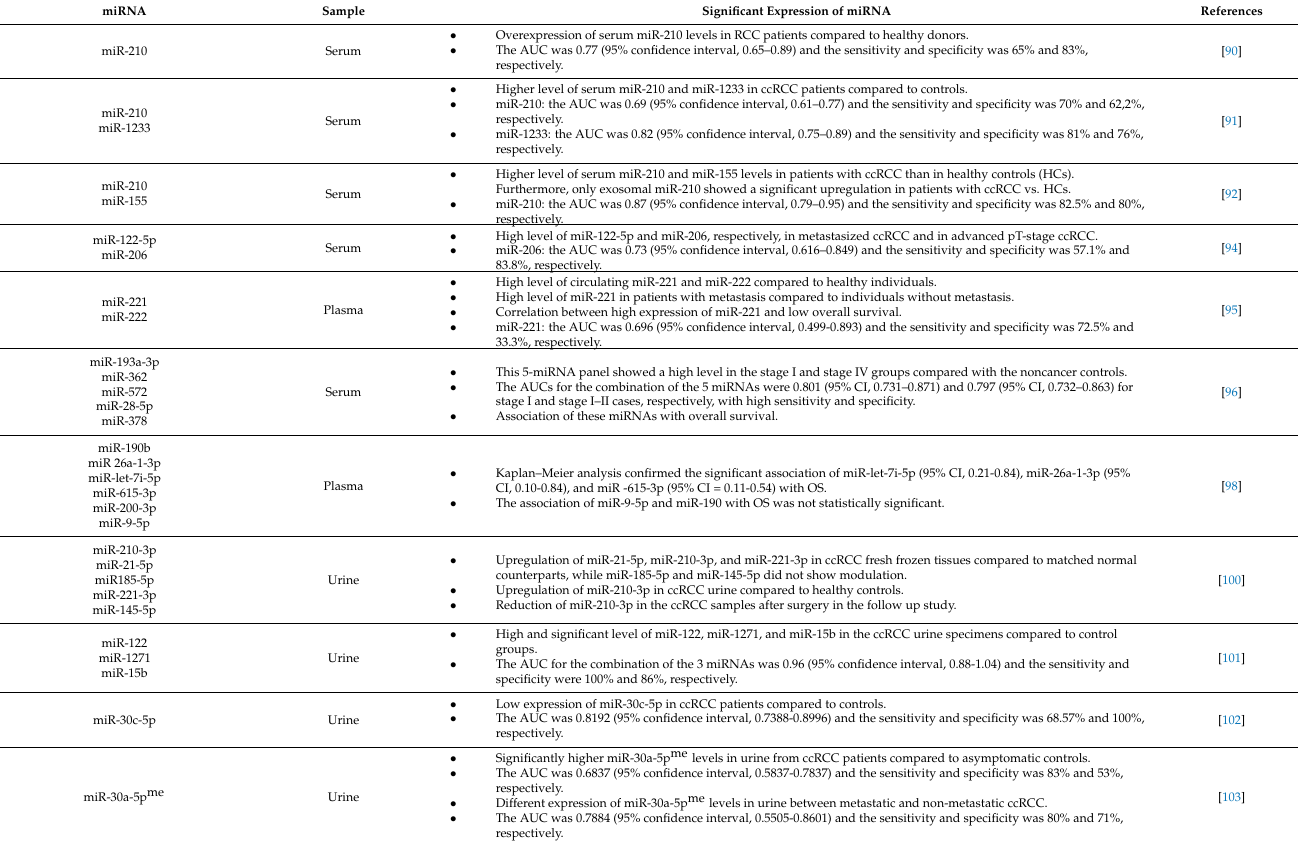
Table 2. microRNAs in blood and urine as potential biomarkers in